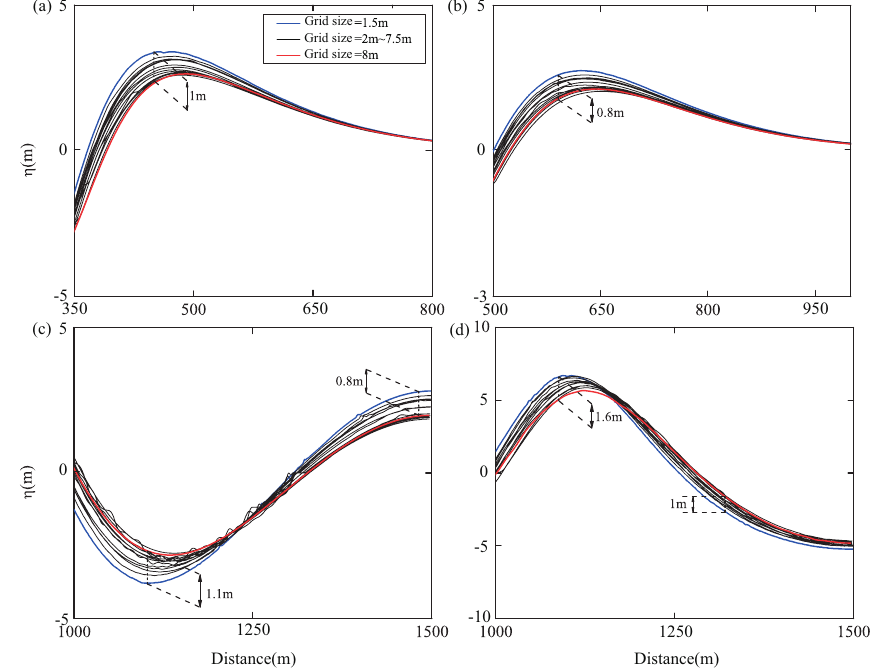
Figure 7. Calculation results of uniform mesh of different sizes in the propagation field: ( a ) t = 15 s; ( b ) t = 20 s; ( c ) t = 50 s; and ( d ) t = 60